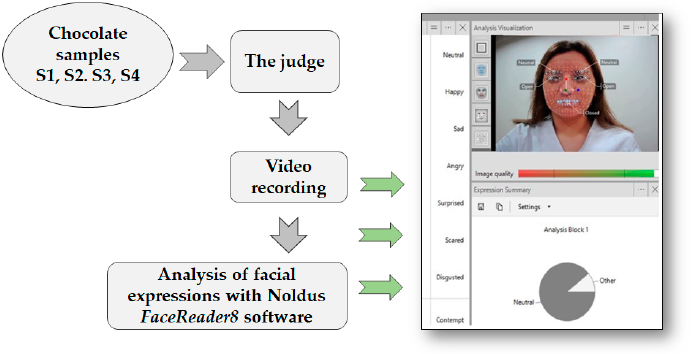
Figure 2. The experimental scheme used to evaluate the emotions elicited by different chocolate samples. Permission to use the original picture is provided by the coauthor E. Zokaityte.